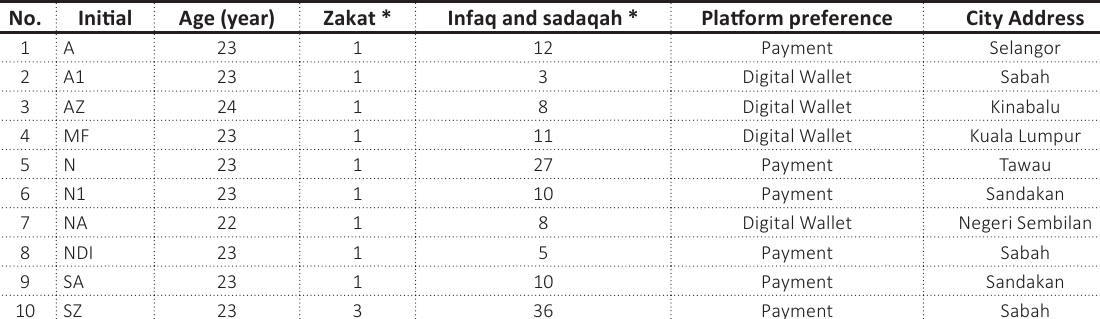
Source: Data owned and processed by the